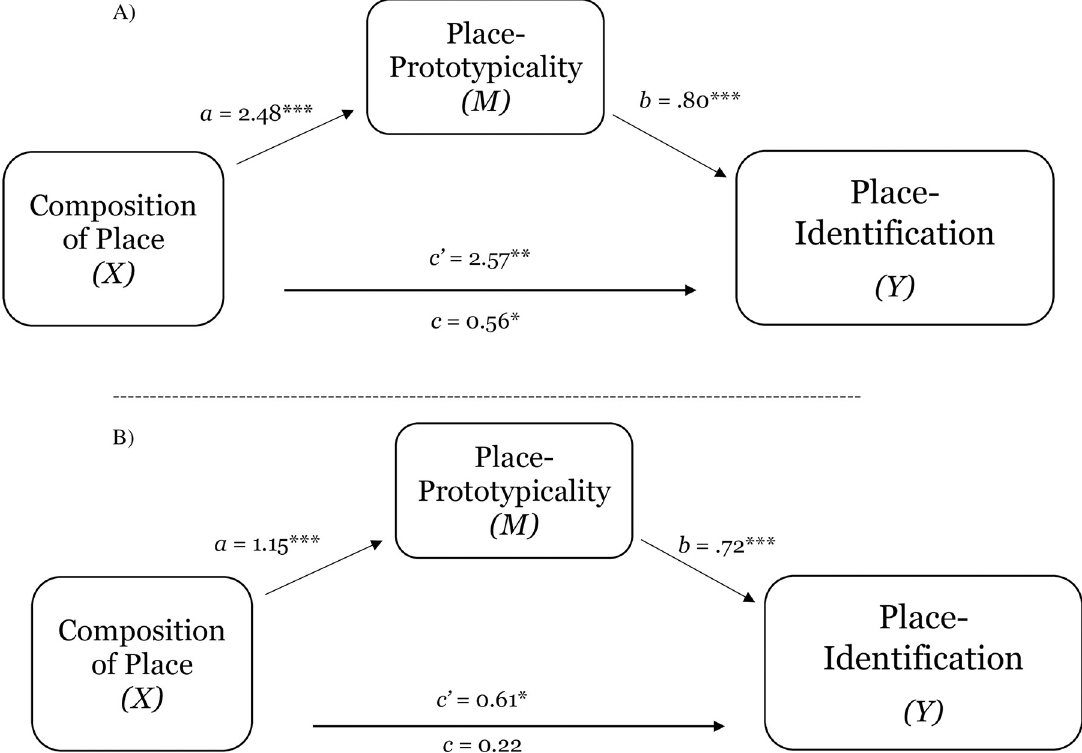
Fig 4. Test of the mediating effect of place-prototypicality on the relation between composition of place and place-identification (sense of belonging) in Study 1d (Panel A) and Study 1e (Panel B). Notes: � p < .05, �� p < .01, ��� p < .001.